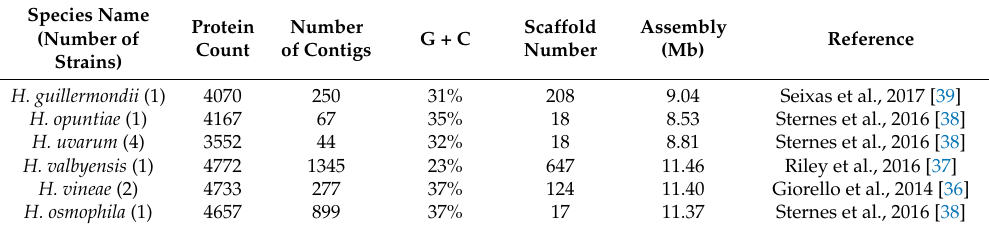
Table 1. Hanseniaspora genome assembly